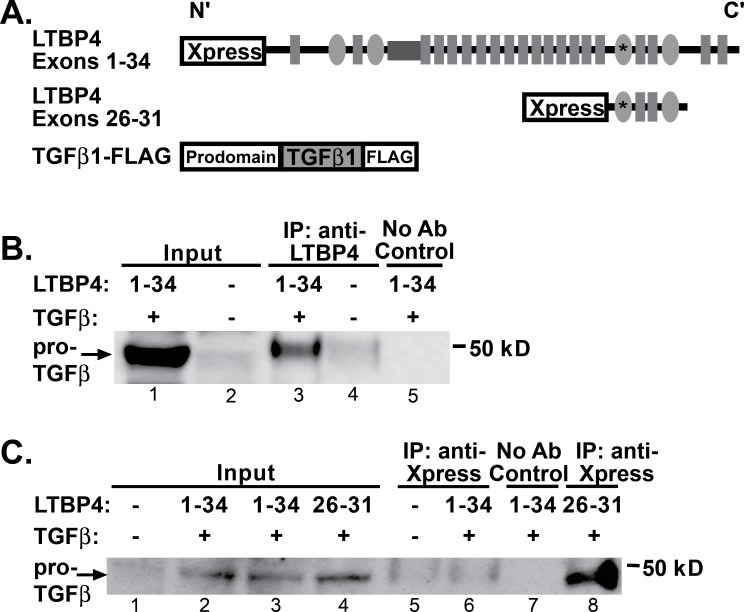
TGFβ1 binds the carboxy terminus of LTBP4.A. HEK293T cells were transfected with human constructs to express LTBP4 and TGFβ1. B. Immunoprecipitation was performed from cell lysates by immunoprecipitating with an anti-LTBP4 antibody followed by immunoblotting with anti-FLAG antibody, which detected an interaction between LTBP4 and pro-TGFβ1. The immunoblot shows that full length LTBP4 binds TGFβ1. C. Co-immunoprecipitation was performed on cell lysates by immunoprecipitating with anti-Xpress antibodies to the epitope tag on LTBP4 followed by immunoblotting with anti-FLAG antibody detecting TGFβ1. The carboxy terminal fragment of LTBP4 associated with TGFβ1. Controls were performed without adding immunoprecipitating antibody.